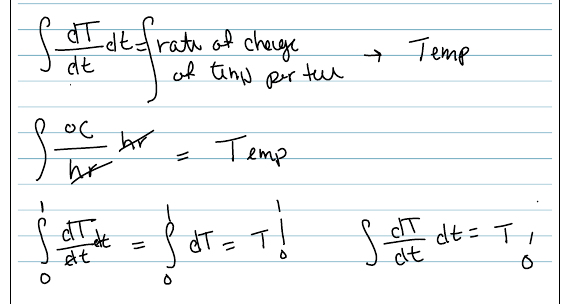
FIG. 6. Kara ’ s analytical derivation game to solve the temper- ature